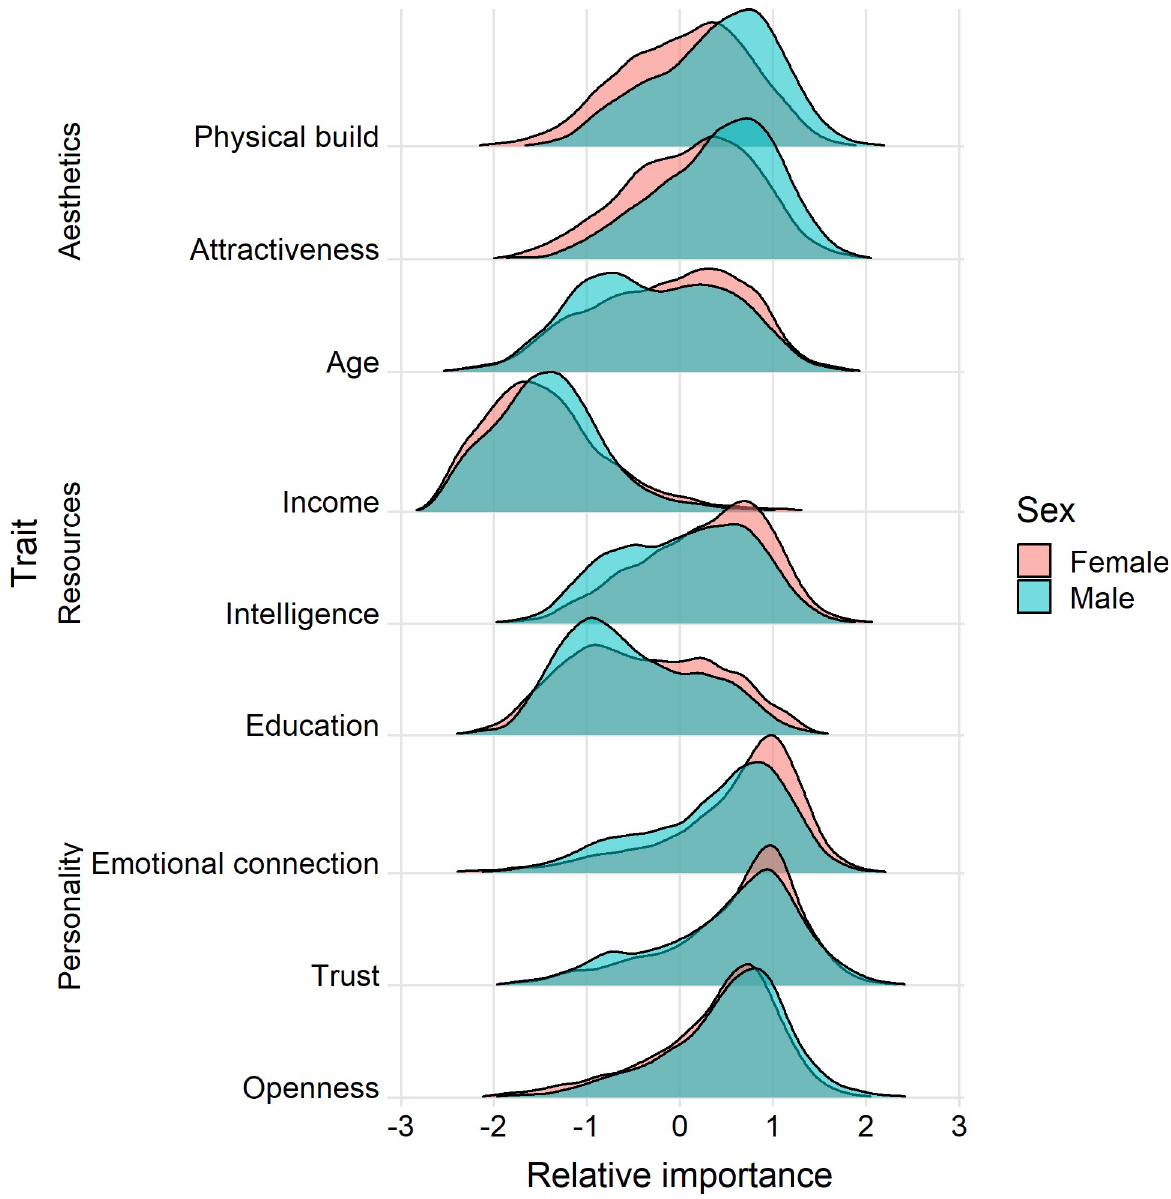
Fig 1. Relative importance of aesthetics, resources, and personality factors for sexual attraction, by sex. Distribution density for each factor is estimated within sex.